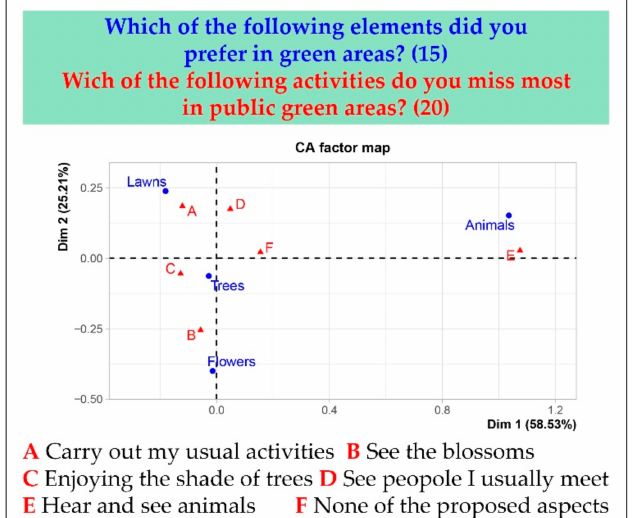
Figure 7. CA results for the relationship between the respondent use of public green areas and favorite elements before the social distancing period and the perception about them during social distancing (questions 15–20).